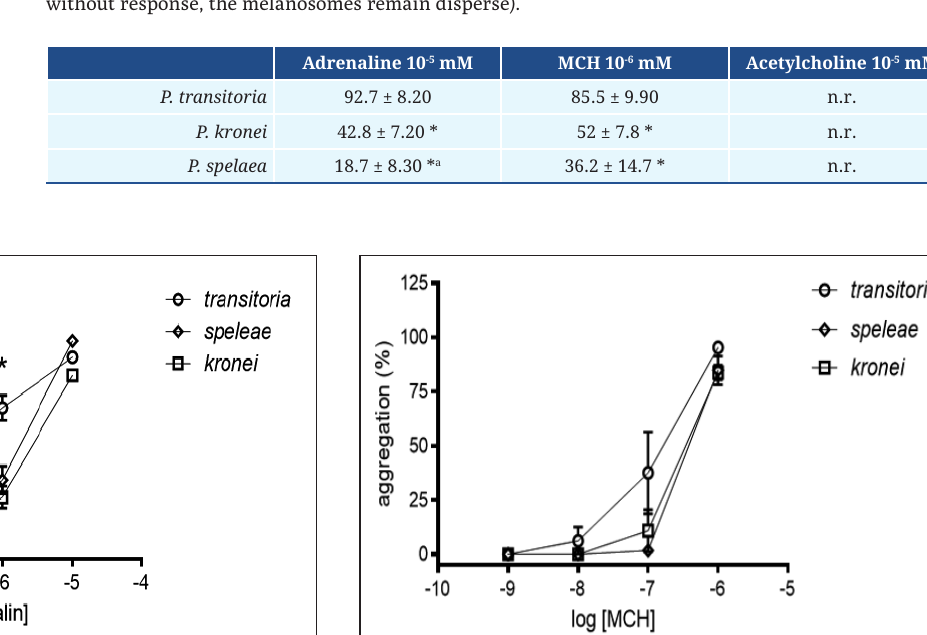
TABLE 2 | Percentages of cells with fully aggregated melanosomes in response to hormones in the studied species (* p ≤ 0.05 in comparisons with P. transitoria , * a different also from P. kronei ) (n.r. without response, the melanosomes remain disperse).